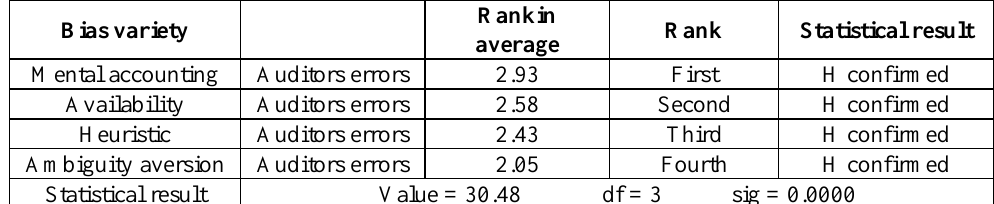
Table (5) Findings of each bias effect over auditors’ errors Bias